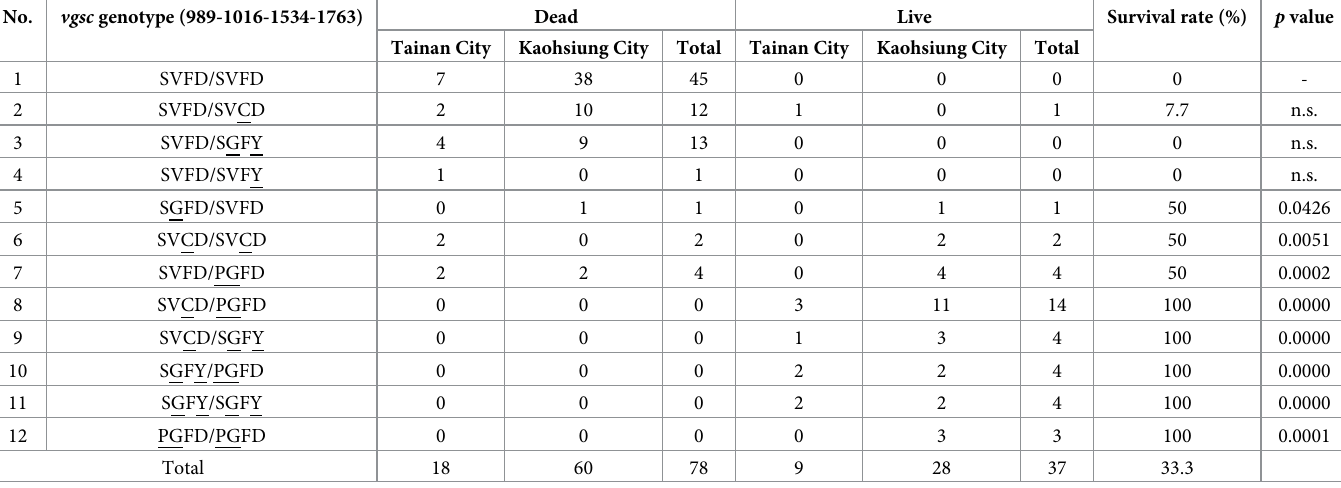
Table 4. The distribution of combined vgsc genotypes in live and dead G1 female after cypermethrin exposure bioassay. Genotype was described as the composition of two haplotypes and underlined letter represents the mutant alleles in each